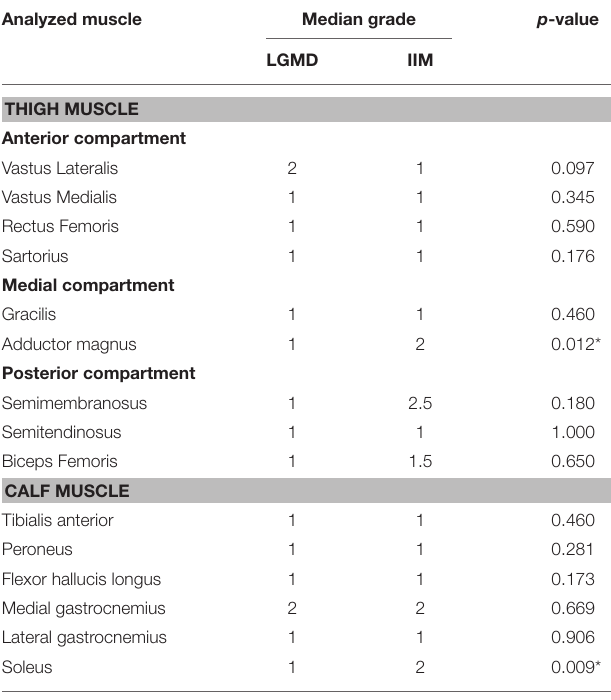
TABLE 3 | Comparison of the grades of muscle fat substitution between limb-girdle muscular dystrophy and idiopathic inflammatory myopathy. Analyzed muscle